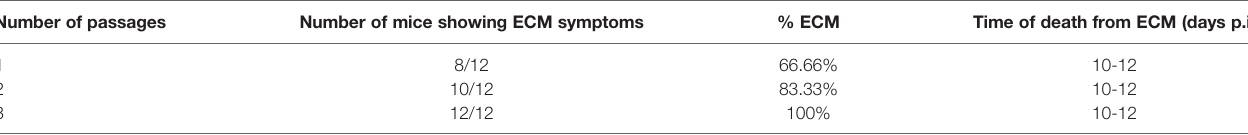
TABLE 1 | P. berghei ANKA was revived from cryopreserved samples and maintained in 6-8 weeks old female C57BL/6 mice (n=12). Number of passages Number of mice showing ECM